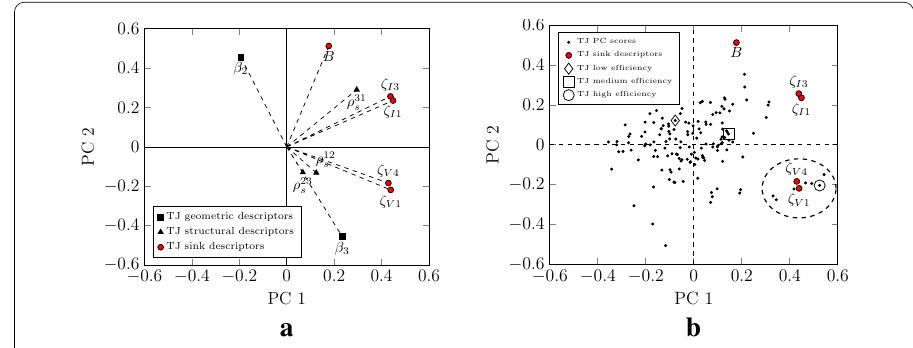
Fig. 2 a Comparisons of the first two principal components (PCs) for the geometric/structural and sink descriptors for the triple junction (TJ). The variable correlations within the first two principal components space are tabulated in Table 1, while the correlation coefficients between the TJ geometrical and structural descriptors are listed in Table 2. b PC scores for all 144 TJ configurations with respect to the first two principal components. Open symbols corresponds to three illustrative TJ regions with low, medium and high sink efficiencies. The dashed elliptical region corresponds to seven TJ with the highest PC score. Their sink